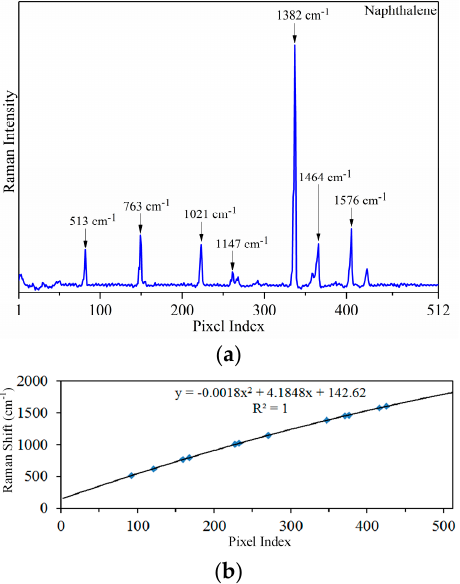
Figure 2. Raman spectrum of naphthalene for spectral calibration ( a ); quadratic fitting of naphthalene and polystyrene Raman peaks for spectral calibration ( b ).